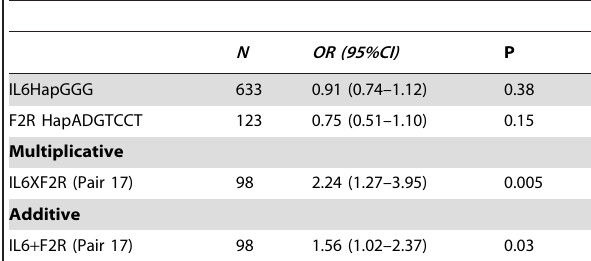
Table 3. Interaction between the IL6 Hap2 and F2R Hap6 on a multiplicative and on an additive